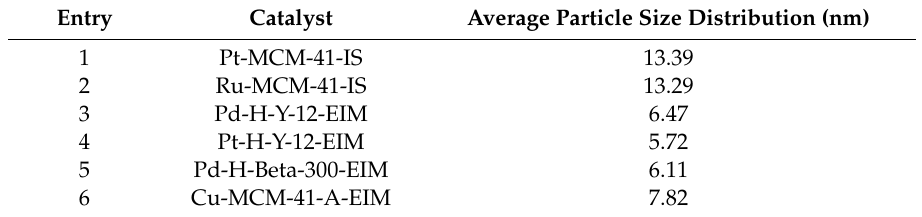
Table 1. Average cluster size distribution of Pt, Ru, Pd and Cu in the catalysts Pt-MCM-41-IS,